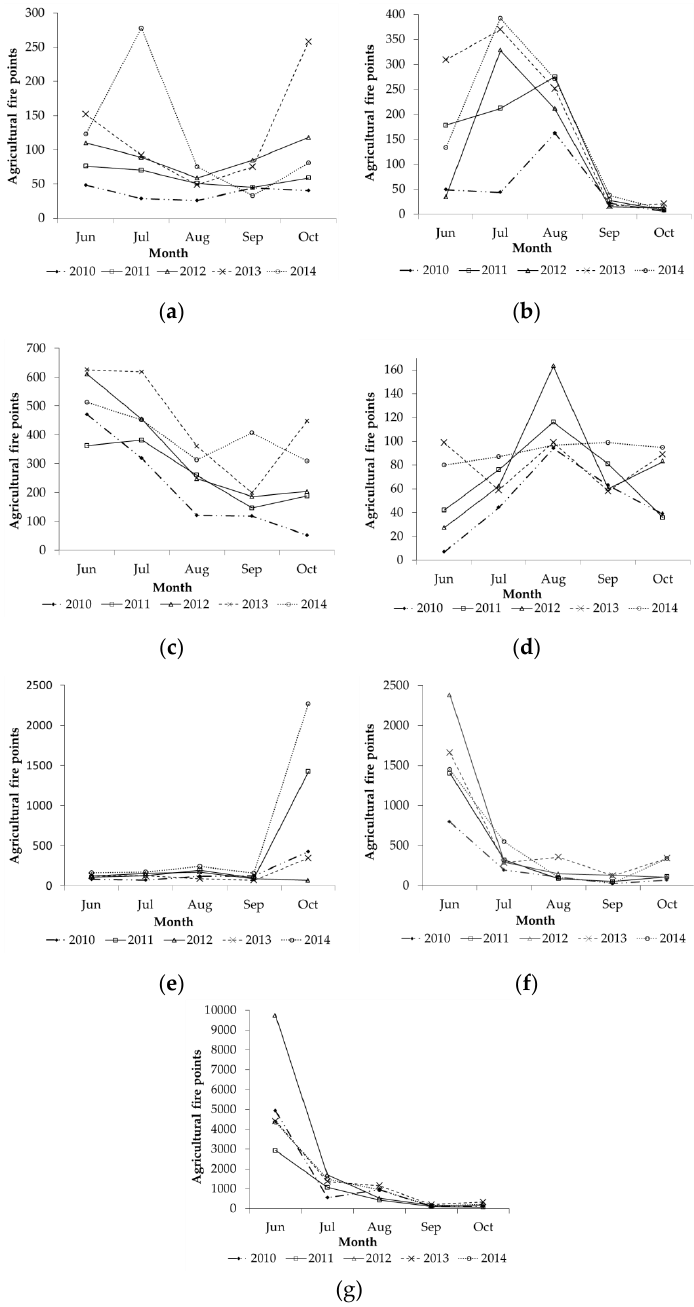
Figure 8. The monthly time series of agricultural fire detection in each region: ( a ) Northwest; ( b ) Southwest; ( c ) North China; ( d ) South China; ( e ) Northeast; ( f ) Central China; ( g ) Eastern